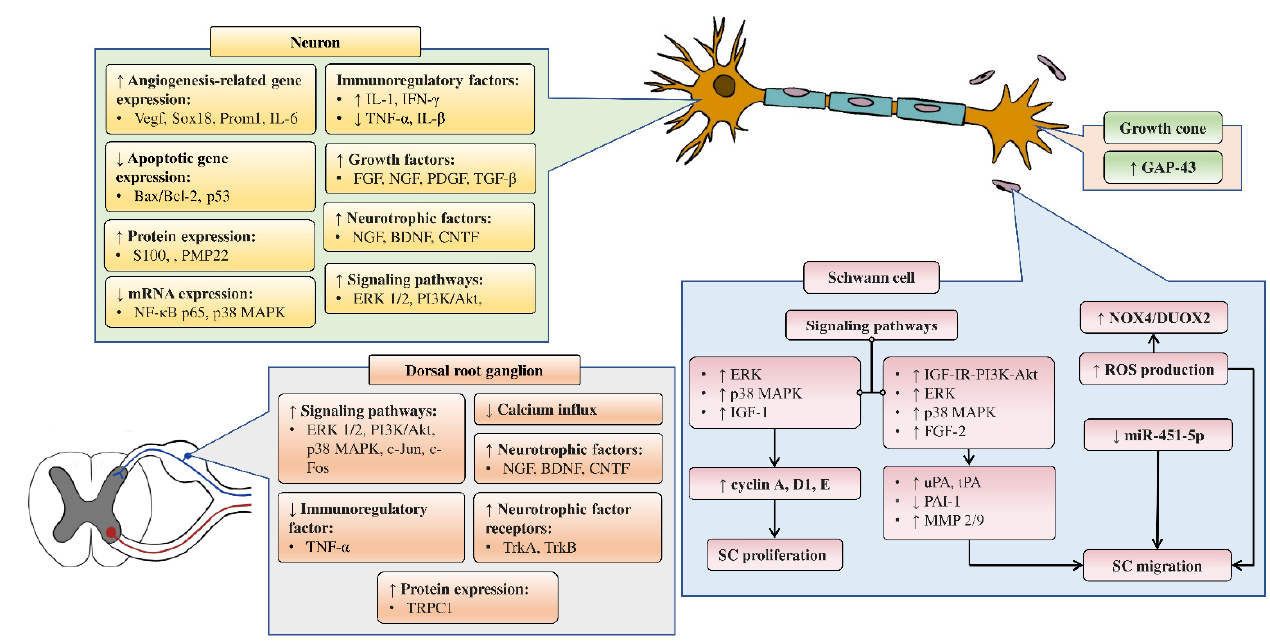
Figure 6. Summary of the molecular mechanisms associated with the neuroregenerative effects of CAMs. Vegf—vascular en- dothelial growth factor; Sox18—sex-determining region Y-box transcription factor 18; Prom1—prominin 1; IL—interleukin; IFN- γ —interferon- γ ; Bax—Bcl-2-associated X protein; Bcl-2—B-cell lymphoma 2; Trk—tropomyosin receptor kinase; PMP22—peripheral myelin protein 22; FGF—fibroblast growth factor; NGF—nerve growth factor; PDGF—platelet-derived growth factor; TGF- β —transforming growth factor- β ; NF- κ B—nuclear factor kappa B; MAPK—mitogen-activated protein kinase; PI3K—phosphoinositide 3-kinase; Akt—protein kinase B; BDNF—brain-derived neurotrophic factor; CNTF—ciliary neurotrophic factor; TNF- α —tumor necrosis factor- α ; TRPC1—transient receptor potential cation channel subfamily C member 1; GAP-43—growth-associated protein 43; PAI-1—plasminogen activator inhibitor-1; MMP2/9—ma- trix-metalloproteinase-2/9; tPA—tissue plasminogen activator; uPA—urokinase plasminogen activator.